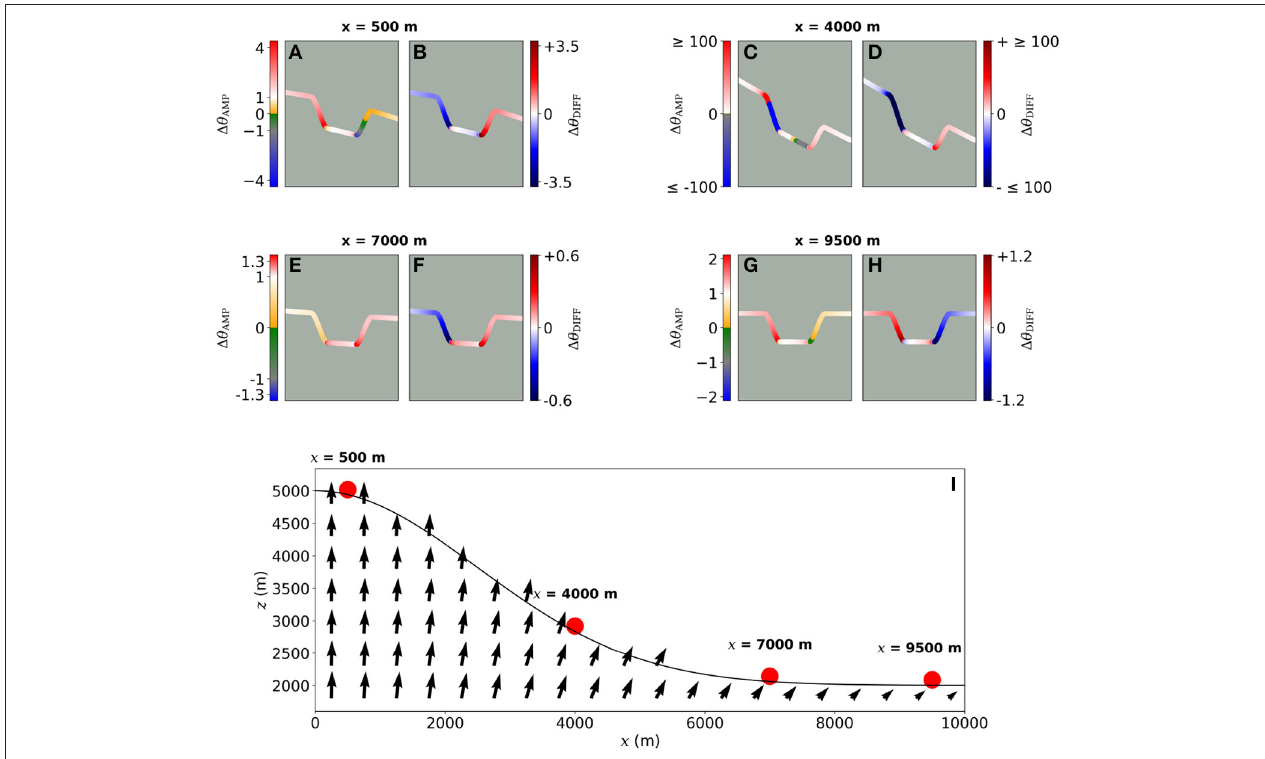
FIGURE 5 | (A–H) Amplification factor and difference due to the topographic effect on tilt generated by reservoir pressure, where opposing slopes are included at either x = 500, 4,000, 7,000, or 9,500 m, as indicated by red dots. (I) Amplitude and orientation of the displacement field produced by reservoir pressure.